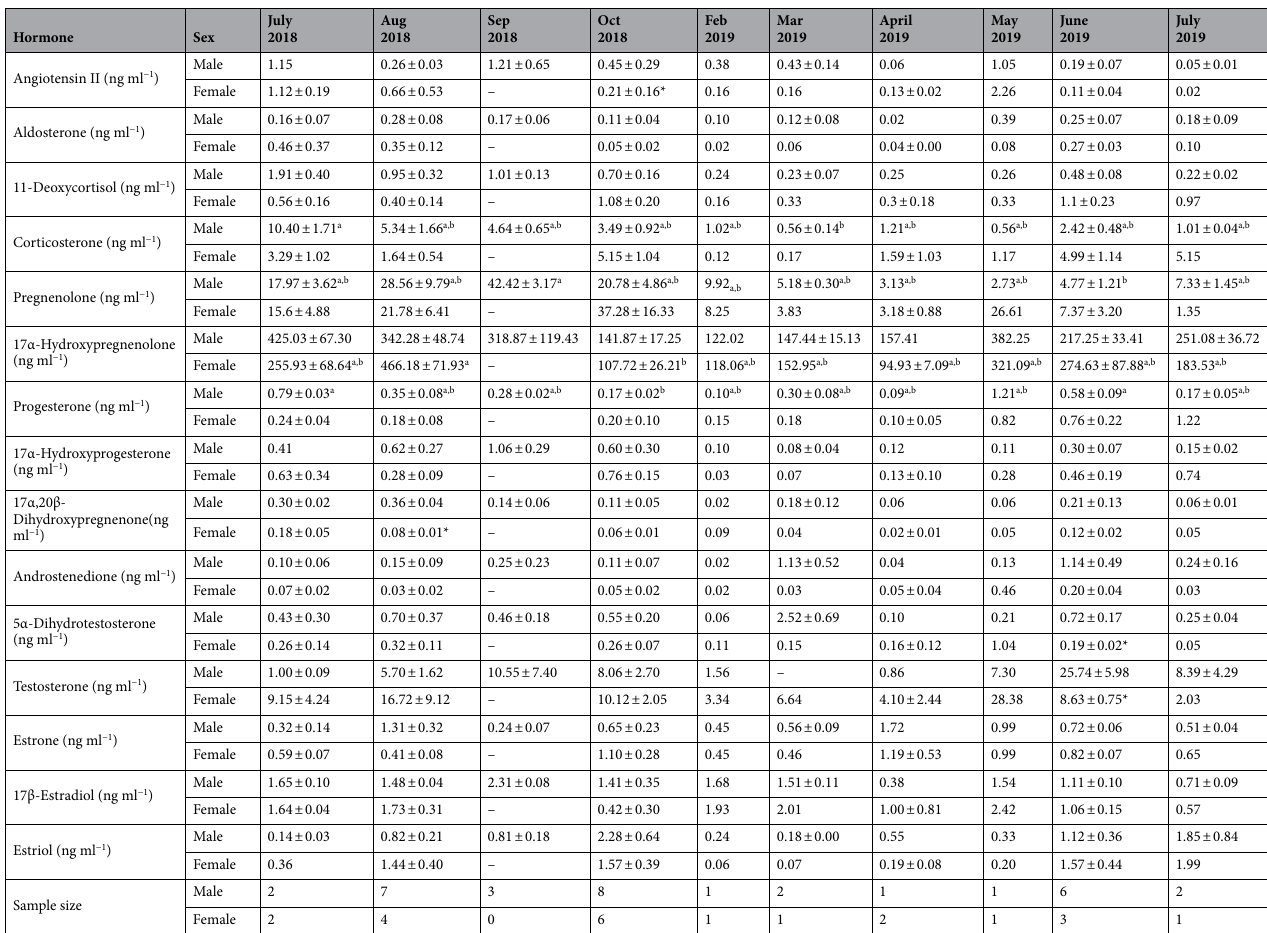
Table 3. Plasma hormone levels in wild juvenile American alligators ( Alligator mississippiensis ). Dissimilar letters show significant differences between months for the given sex. *Significant difference between males and females during the indicated month (p < 0.05). †Values below detection limit. Values shown are averages ± SEM. SEM is not shown in cases where data was only obtained from one